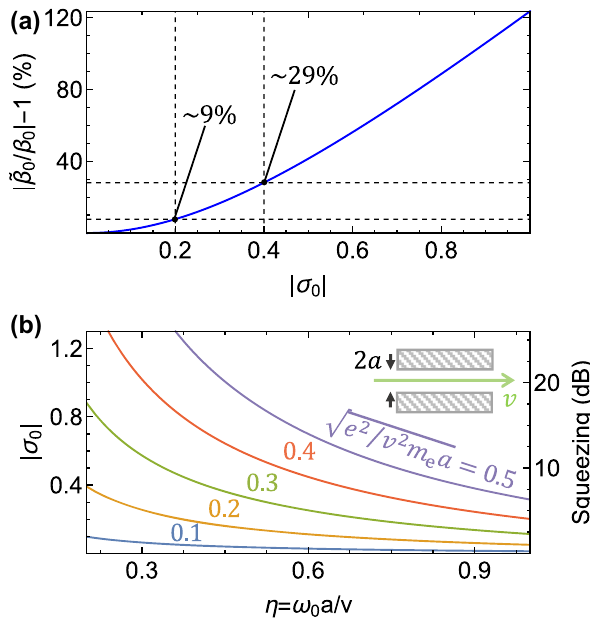
Figure 2: Linear and quadratic coupling in phase-matched ̃𝛽 | from interactions. (a) Deviation of the linear coupling coefficient | 0 | as a the value obtained by neglecting the ponderomotive force | 𝛽 0 | for a phase-matched interaction with real 𝜂 function of | 𝜎 [see 0 i | (left vertical axis) Eqs. (3) and (8a)]. (b) Squeezing parameter | 𝜎 0 | dB (right vertical axis) as a function of and squeezing factor 20 | 𝜎 0 𝜂 = 𝜔 ∕ 𝑣 for different values of 𝑣 2 a under the electron–cavity 0 a configuration depicted in the inset, in which the e-beam moves with velocity 𝑣 along the axis of a cylindrical hole of radius a and the cavity mode consists of a polariton made of a combination of azimuthal numbers m = ± 1 and phase-matched axial wave vector = 𝜔 ∕ 𝑣 q 0 z